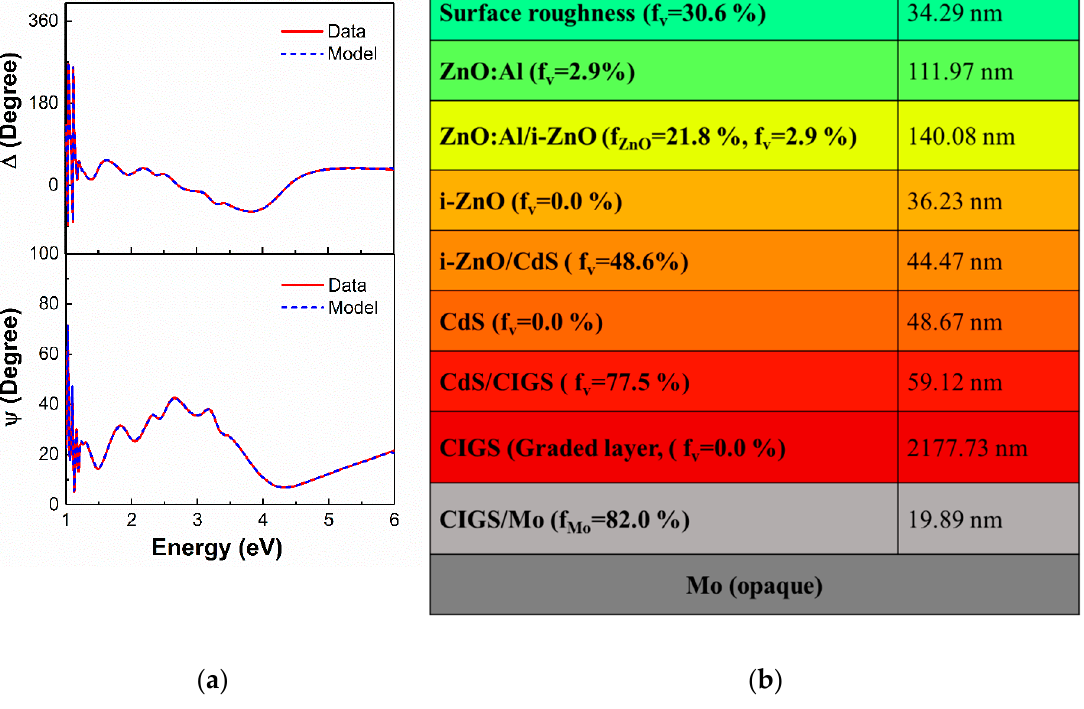
Figure 1. ( a ). Experimental ellipsometric spectra in ψ and ∆ along with the best fit for a specific CIGS solar cell device without an anti-reflective (AR) layer along with ( b ) the layer structure arising from that analysis.